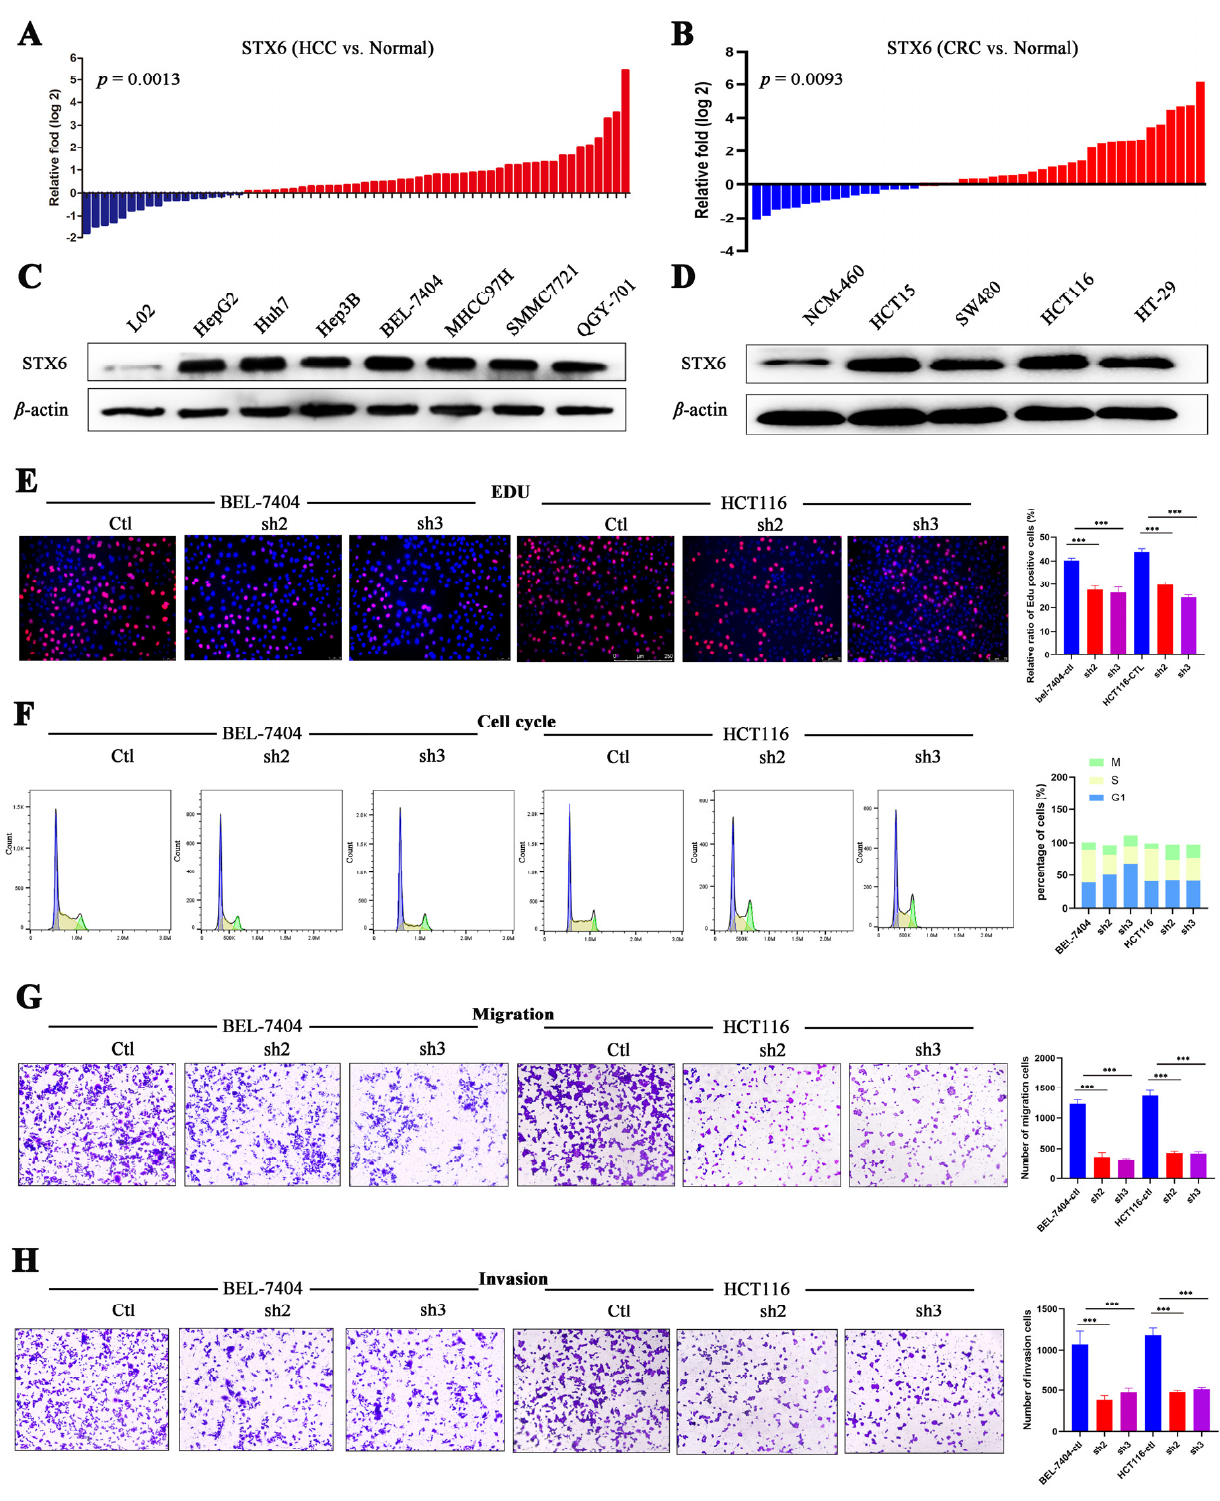
Figure 7. STX6 promotes the proliferation and metastasis of HCC and CRC cells. The mRNA level of STX6 was upregulated in HCC and CRC tissues compared to paired normal samples ( A , B ). In HCC and CRC cell lines, the protein level of STX6 was overexpressed compared to normal cell lines ( C , D ). Knockdown of STX6 expression inhibited the proliferation ( E ), cell-cycle progression ( F ), and cell invasion and migration ( G , H ) of BEL-7404 and HCT-116 cells. *** p < 0.001. The whole Western Blot can be found in file